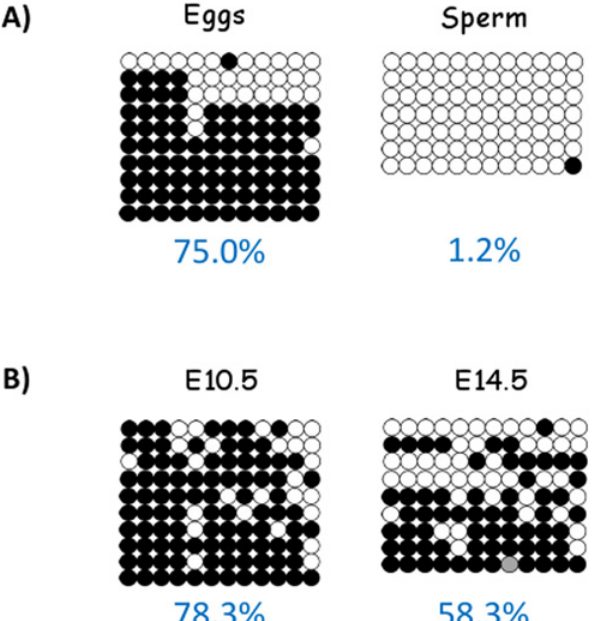
Fig 2. DNA methylation of the P1 promoter during gametogenesis and embryogenesis. The DNA methylation levels of the P1 promoter were analyzed using the DNA isolated from eggs and sperm (A) and E10.5 and E14.5 embryos (B). White and black circles represent unmethylated and methylated CpG dinucleotides, respectively. The overall methylation level of each sample is shown at the bottom.